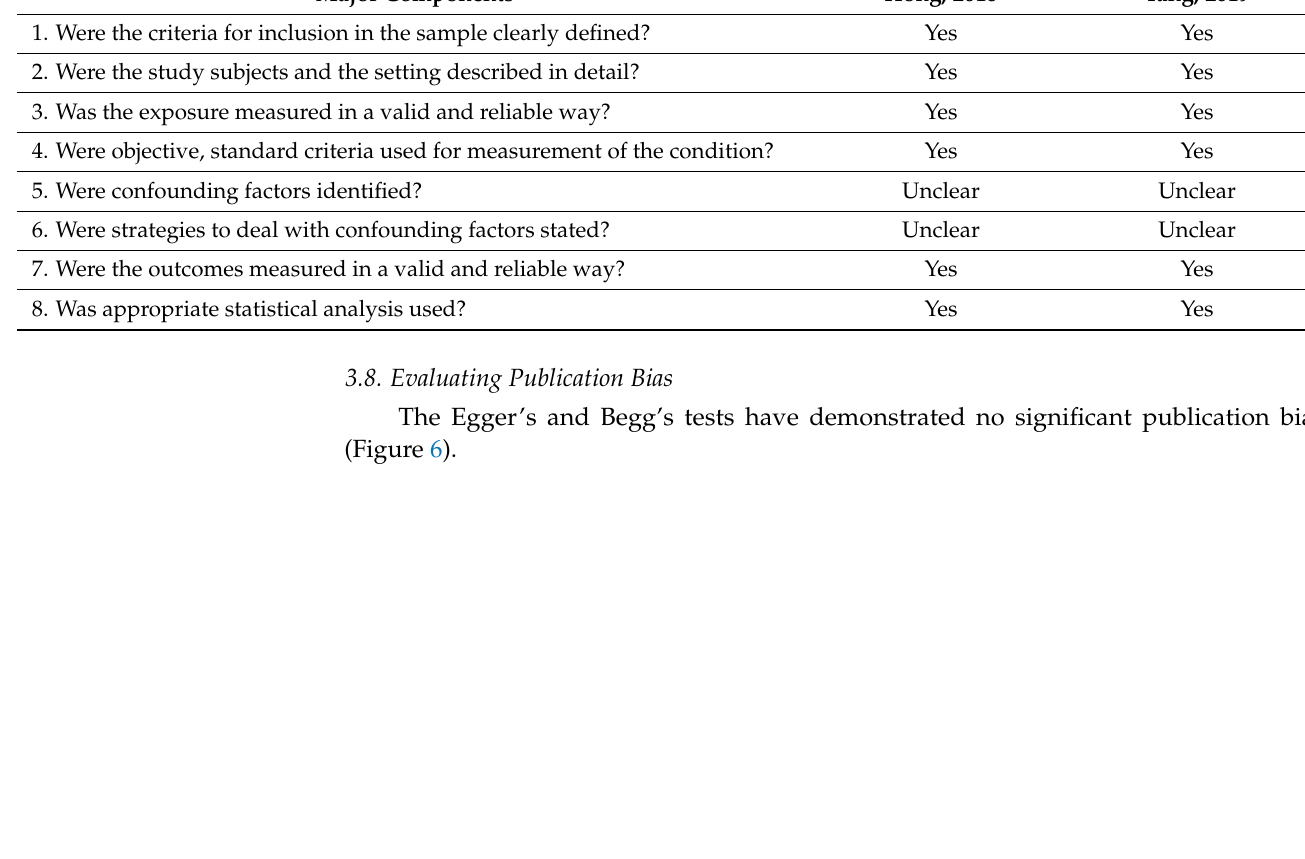
Table 3. Evaluating the potential bias in the included studies based on the JBI critical appraisal checklist. Major